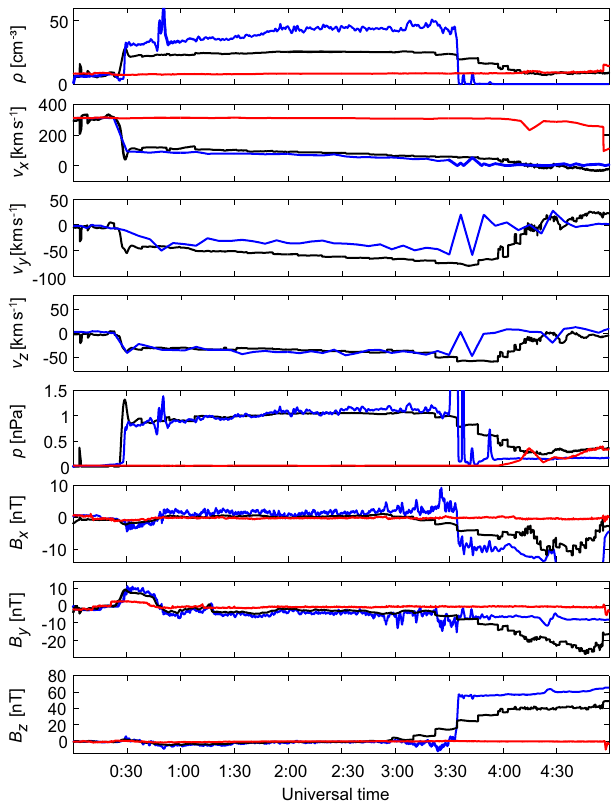
Figure 3. THC magnetosheath data (blue) observed on 24 Au- gust 2008 and the corresponding MHD simulation results (black) using the solar wind observations of THB